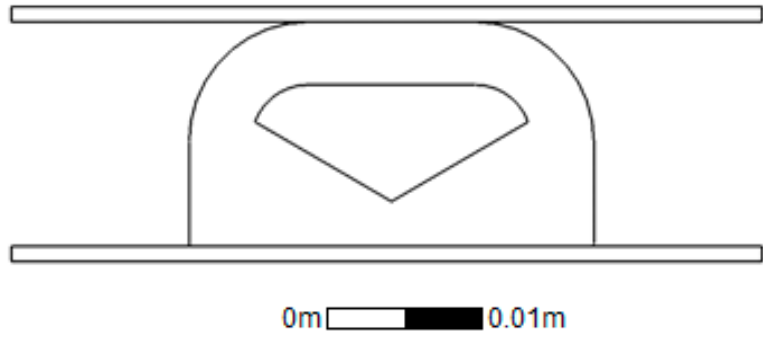
Figure 2. Profile of the D-Shaped EPDM Gasket.